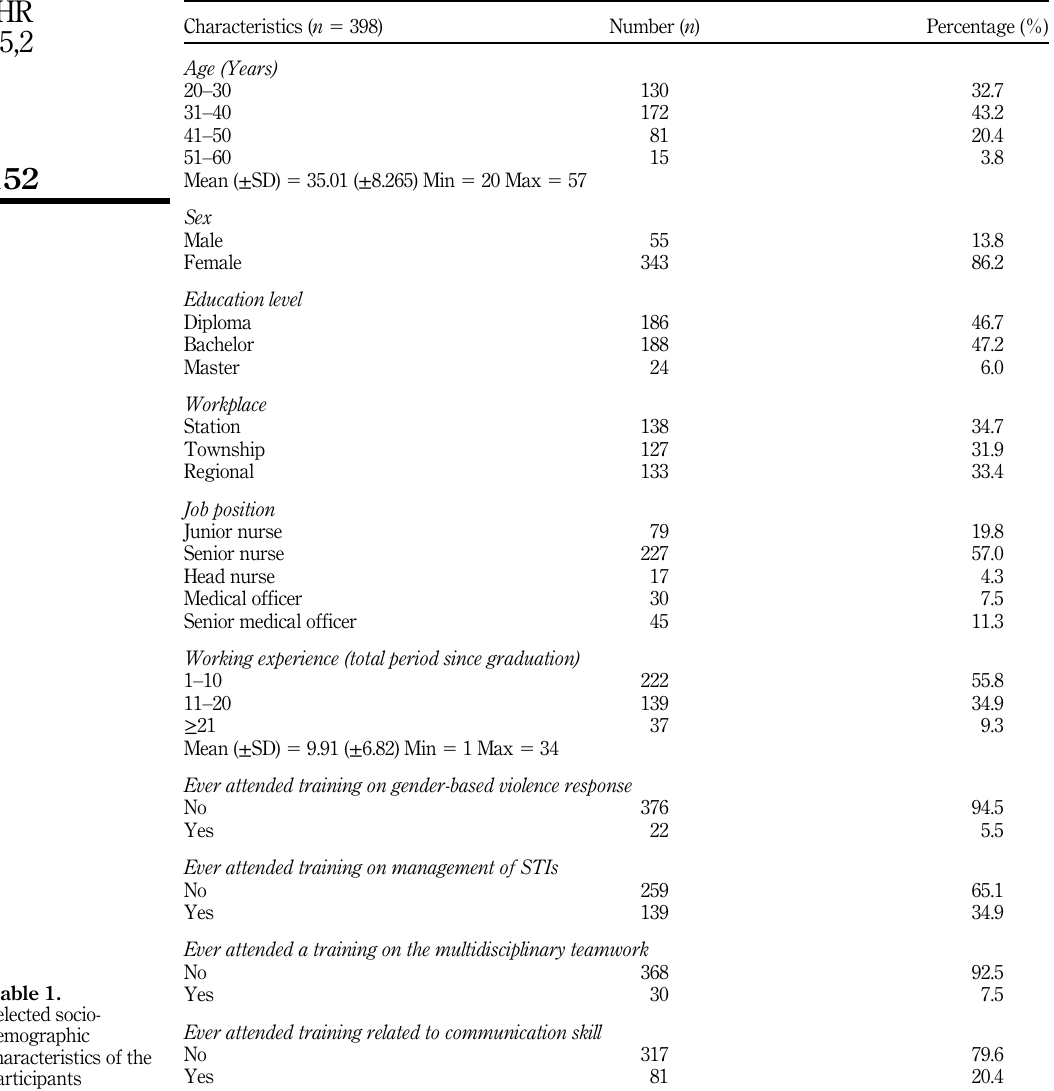
Table 1. Selected socio- demographic characteristics of the